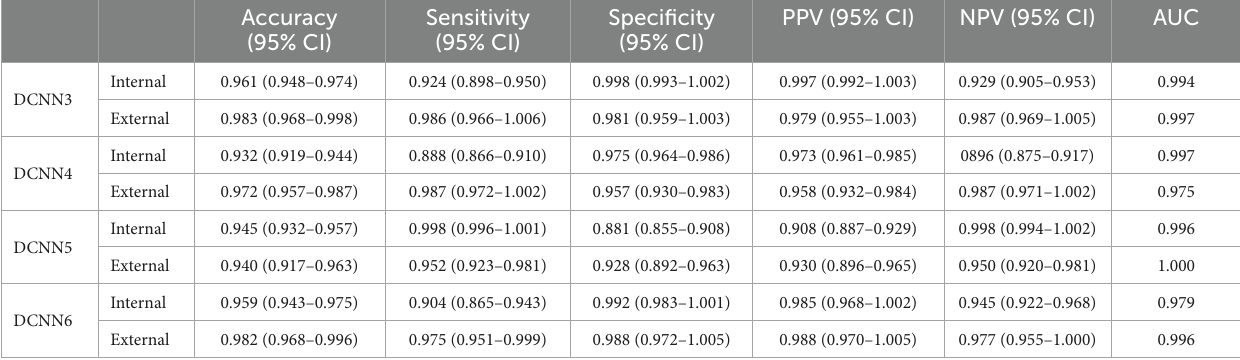
TABLE 1 The classification performance of deep convolutional networks.